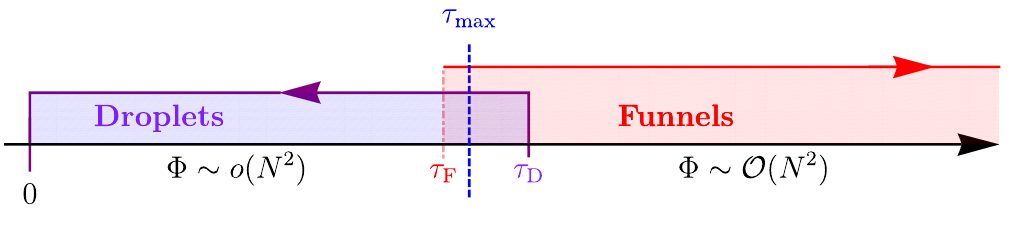
Figure 8 . Phase diagram of N = 4 SYM with gauge group SU( N ) and asymptotic temperature T 1 , at large ’t Hooft coupling and in(cid:12)nite N on a Schwarzschild black hole background with temperature T BH . In this phase diagram (cid:28) (cid:17) T 1 =T BH